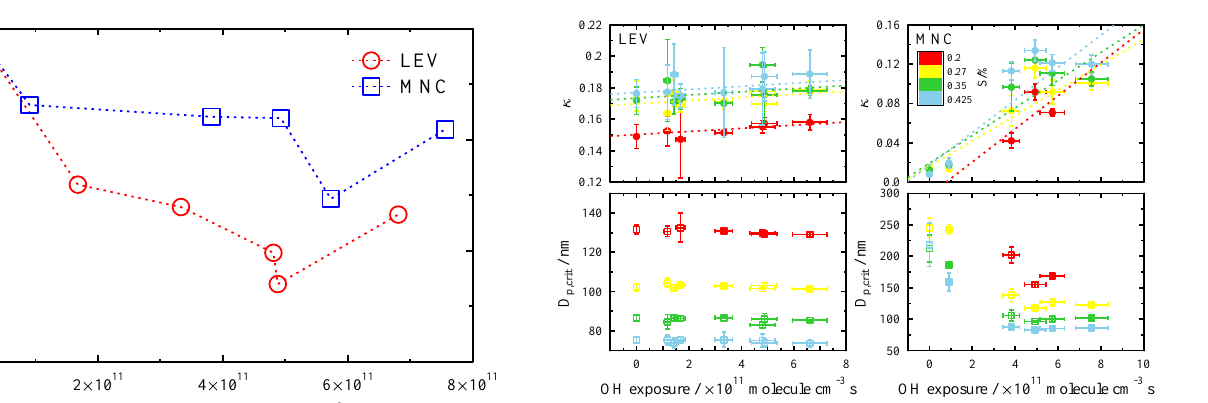
Figure 5. LEV and MNC particle volume change as a function of OH exposure. The measured particle volume in the presence of OH (V; Hg lamp on, with O 3 ) is normalized to the measured particle volume in the absence of OH ( V 0 ; Hg lamp off, with O 3 ).